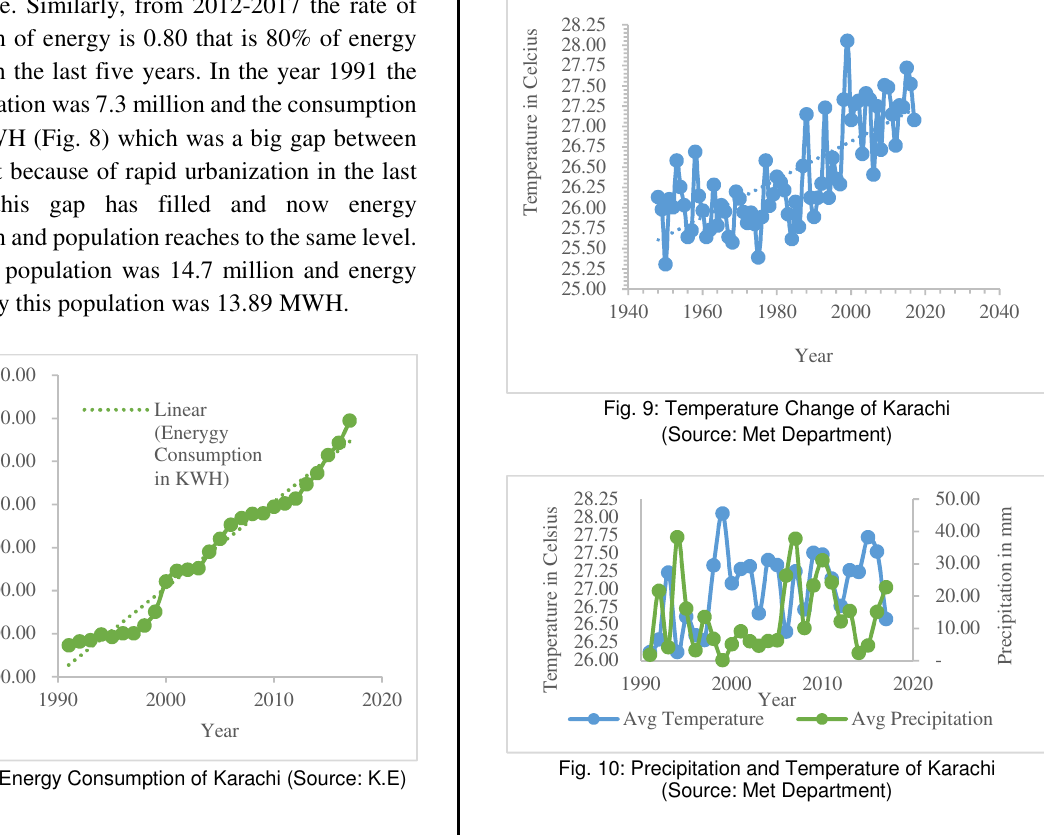
Fig. 7: Total Energy Consumption of Karachi (Source: K.E)